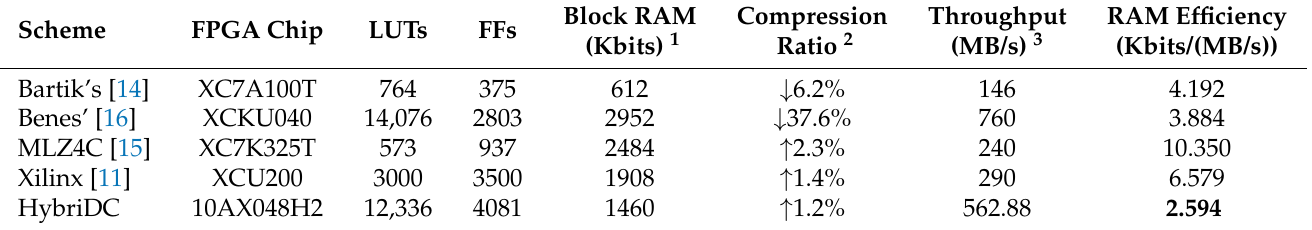
Table 4. The resource utilization and compression performance of different LZ4 acceleration